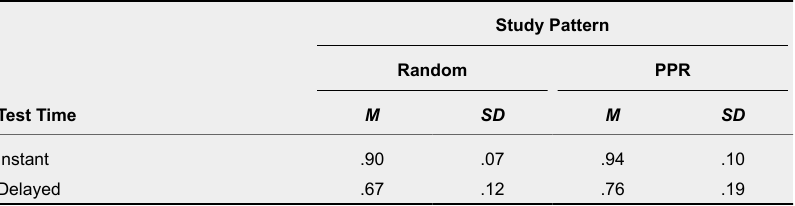
Study Pattern Random PPR Test Time M SD M SD Instant .90 .07 .94 .10 Delayed .67 .12 .76 .19 Note . PPR = previous participants’